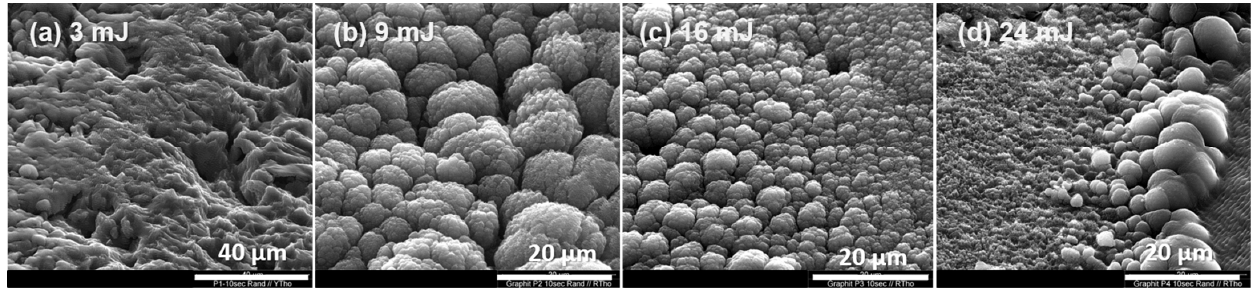
Figure 6. Zone 3. SEM images of graphite targets irradiated with four different pulse energies: ( a ) 3 mJ, ( b ) 9 mJ, ( c ) 16 mJ and ( d ) 24 mJ. Irradiation time: 10 s/150 pulses.